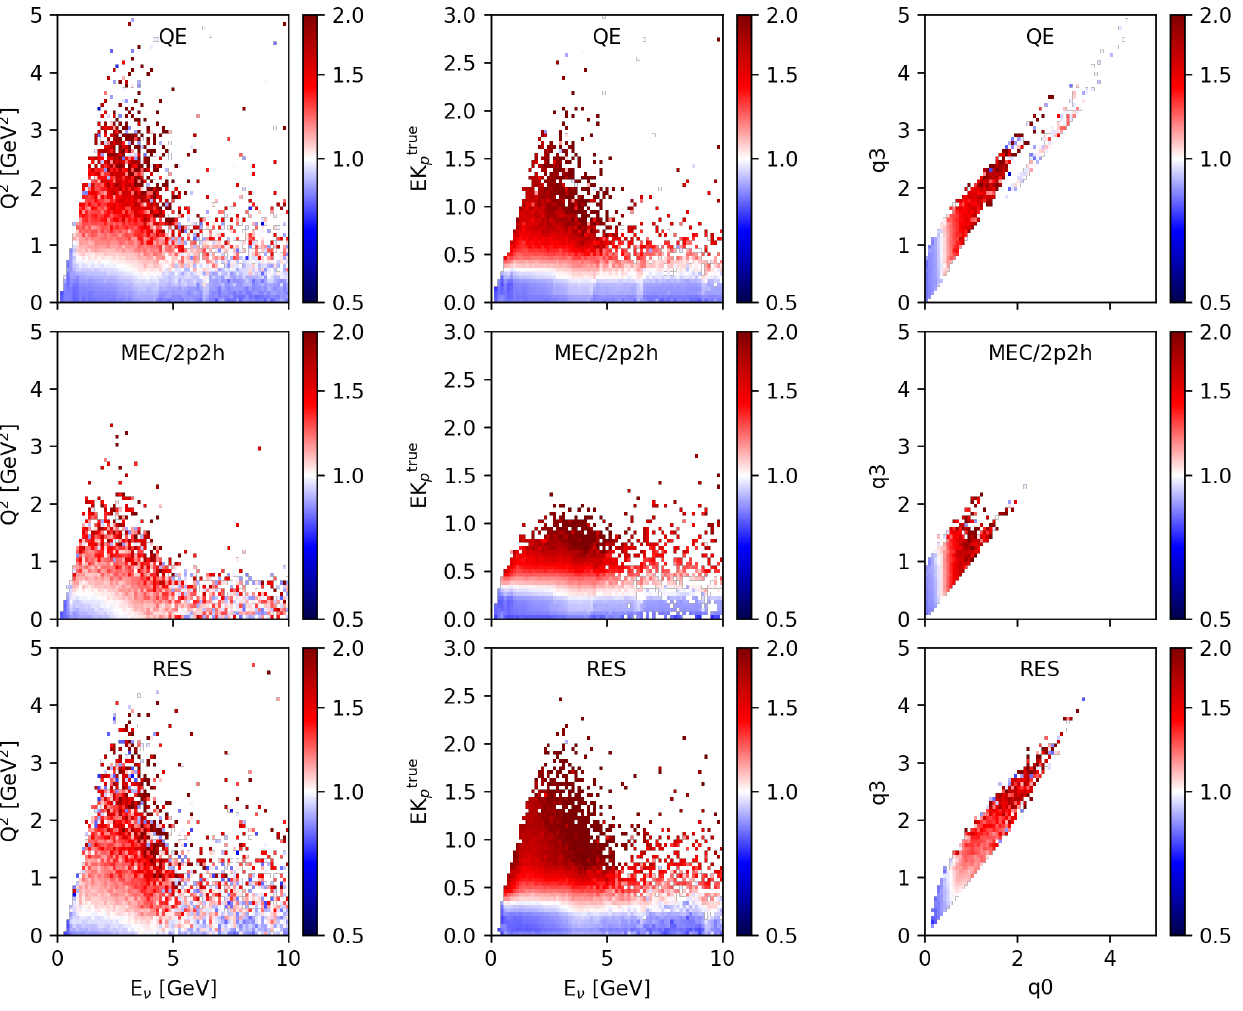
Figure 96. FHC event weights binned in interaction mode and three pairs of true kinematic variables: true neutrino energy vs. Q 2 ( left ); true neutrino energy vs. true proton kinetic energy ( middle ); and q 0 vs. q 3 ( right